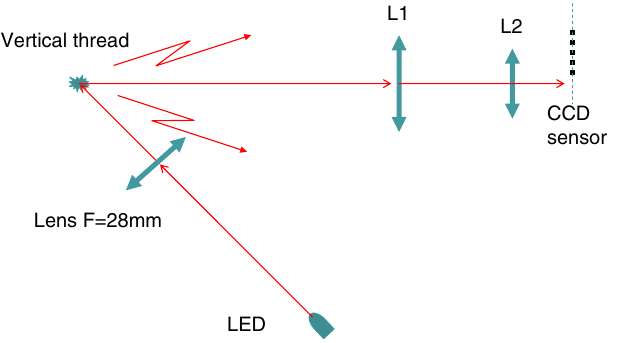
FIG. 8. Sketch of the experimental setup for PSF measurement of the first optics